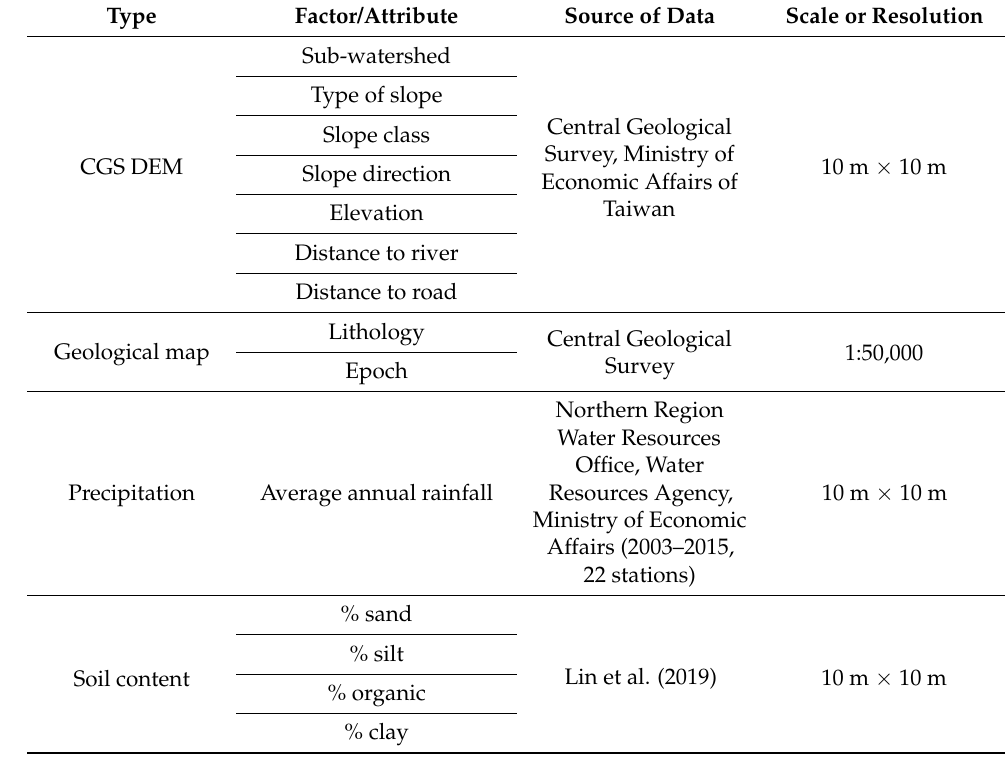
Table 1. The predictive factors used in the modeling of soil erosion pin of the study